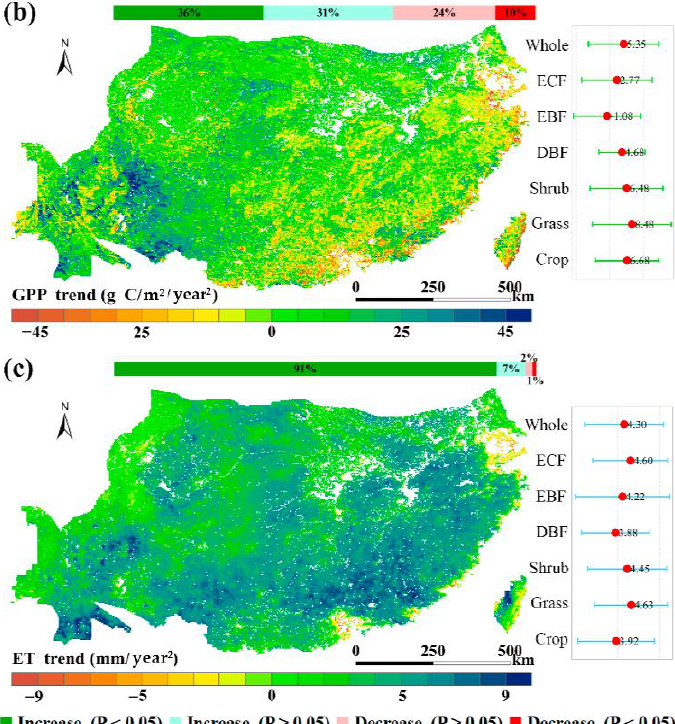
Figure 2. Spatial patterns of interannual trends in ( a ) WUE, ( b ) GPP, and ( c ) ET in subtropical China. The top insets indicate the frequencies of significances; spatial pattern of significances is shown in Figure S2. The right insets indicate the interannual trends of WUE, GPP, and ET of different landscapes, with whiskers indicating the standard deviation of all grid cell values.